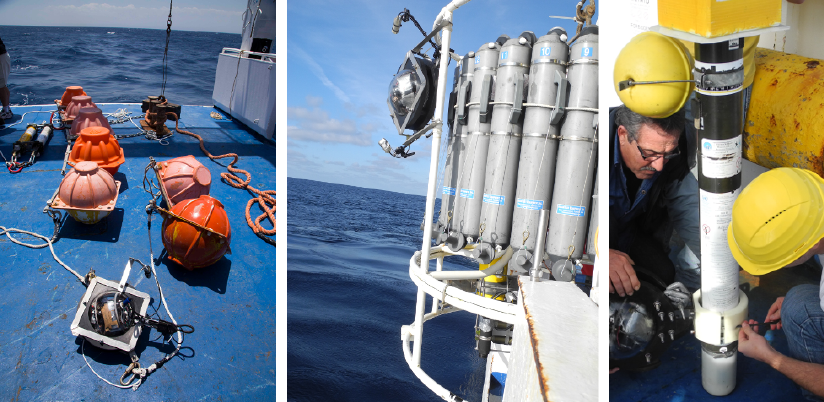
Figure 1. The GUARD1 autonomous imaging system in three of its possible configurations: on the left panel it is hosted on a mooring chain; in the middle panel it is mounted on a rosette; on the right panel it is hosted onboard an ARVOR